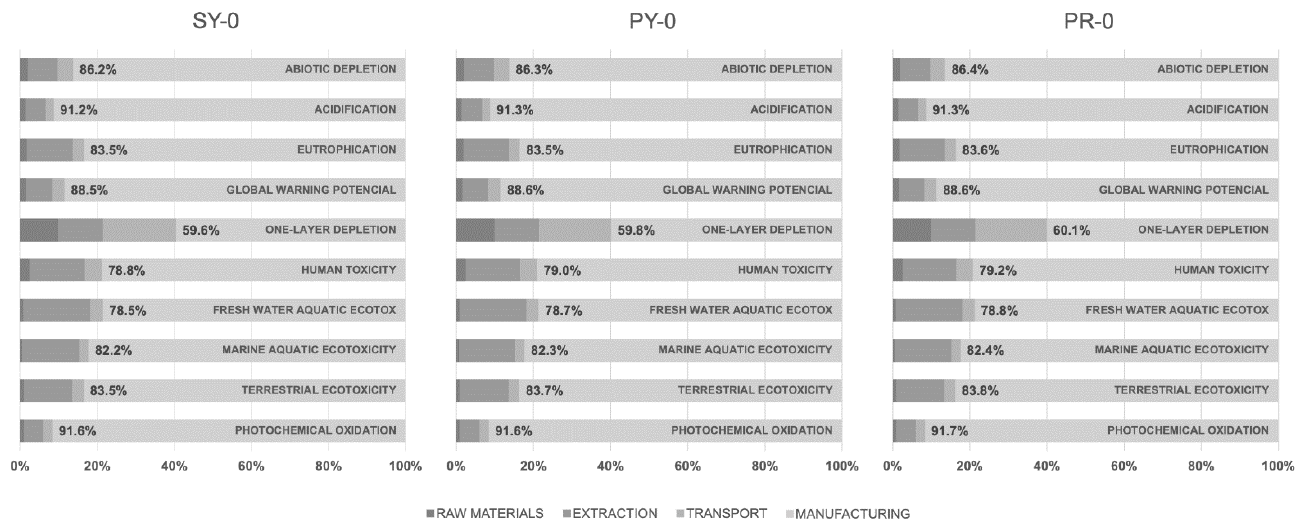
Figure 3. Contribution of characterized impacts associated with 1 kg of lightweight aggregates manufactured without any residue from different stages of production (Scenario 0).